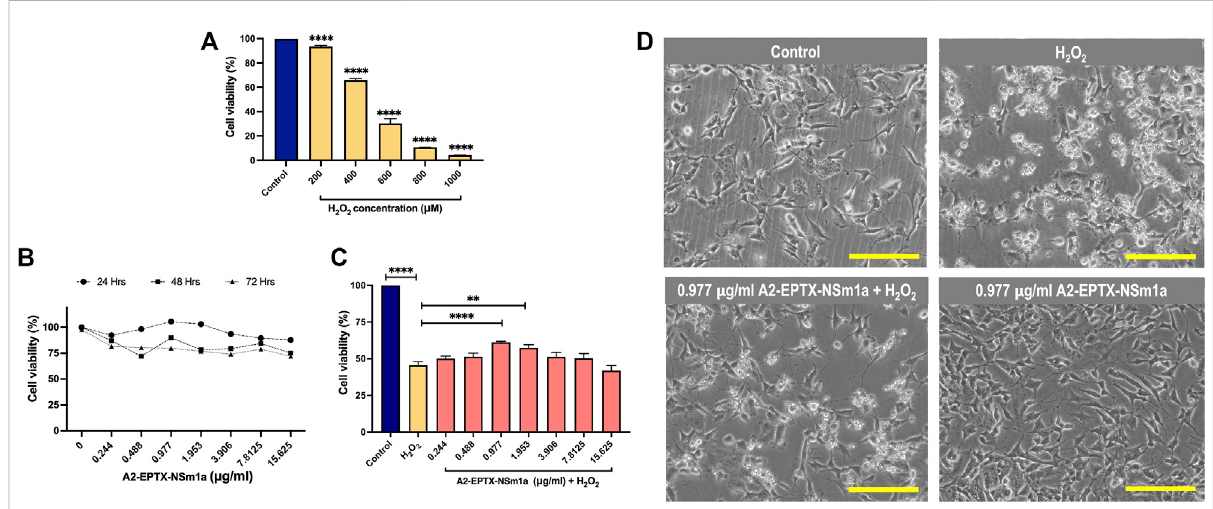
FIGURE 2 CellproliferationandneuroprotectionofasecretoryphospholipaseA2,A2-EPTX-NSm1aindifferentiatedSH-SY5Ycelllines. (A) Cytotoxicityof H 2 O 2 on differentiated SH-SY5Y cells. (B) Cell proliferation of A2-EPTXNSm1a was evaluated at different times of incubation. (C) Neuroprotection assayofA2-EPTX-NSm1a. (D) PhasecontrastofdifferentiatedSH-SY5Yinthedifferentgroups-untreated(control),H 2 O 2 only(oxidativegroup),pre- treatment of 0.977 µg/ml A2-EPTX-NSm1a followed by H 2 O 2 and 0.977 µg/ml A2-EPTX-NSm1a only after 24 h of incubation time. Scale bar = 200 μ M.